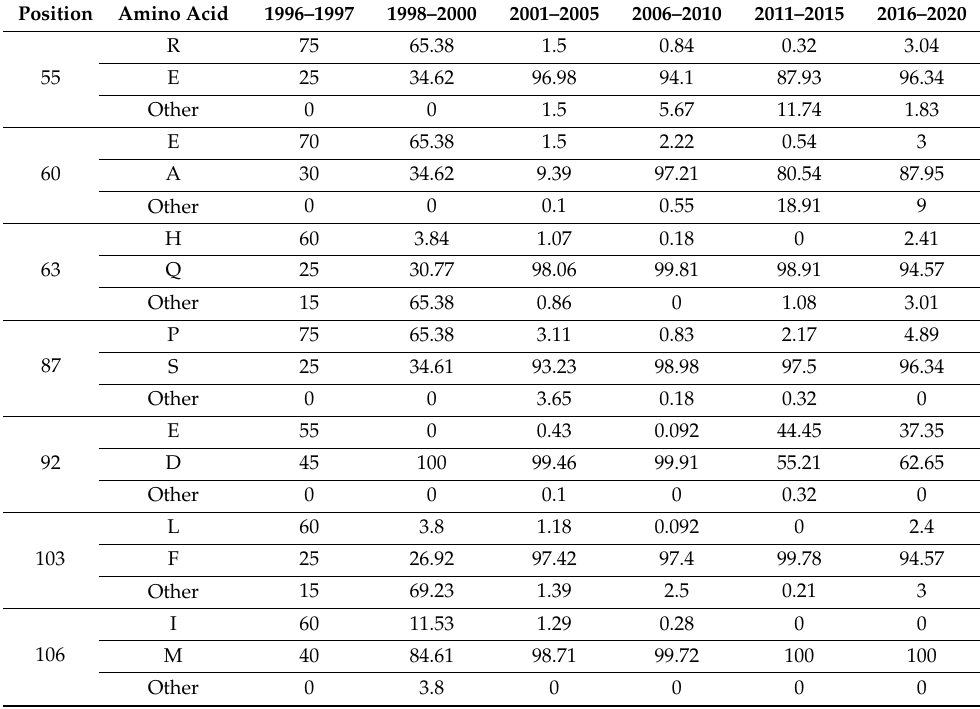
Table 3. Amino acid changes in NS1 proteins from H5N1 IAV isolated in